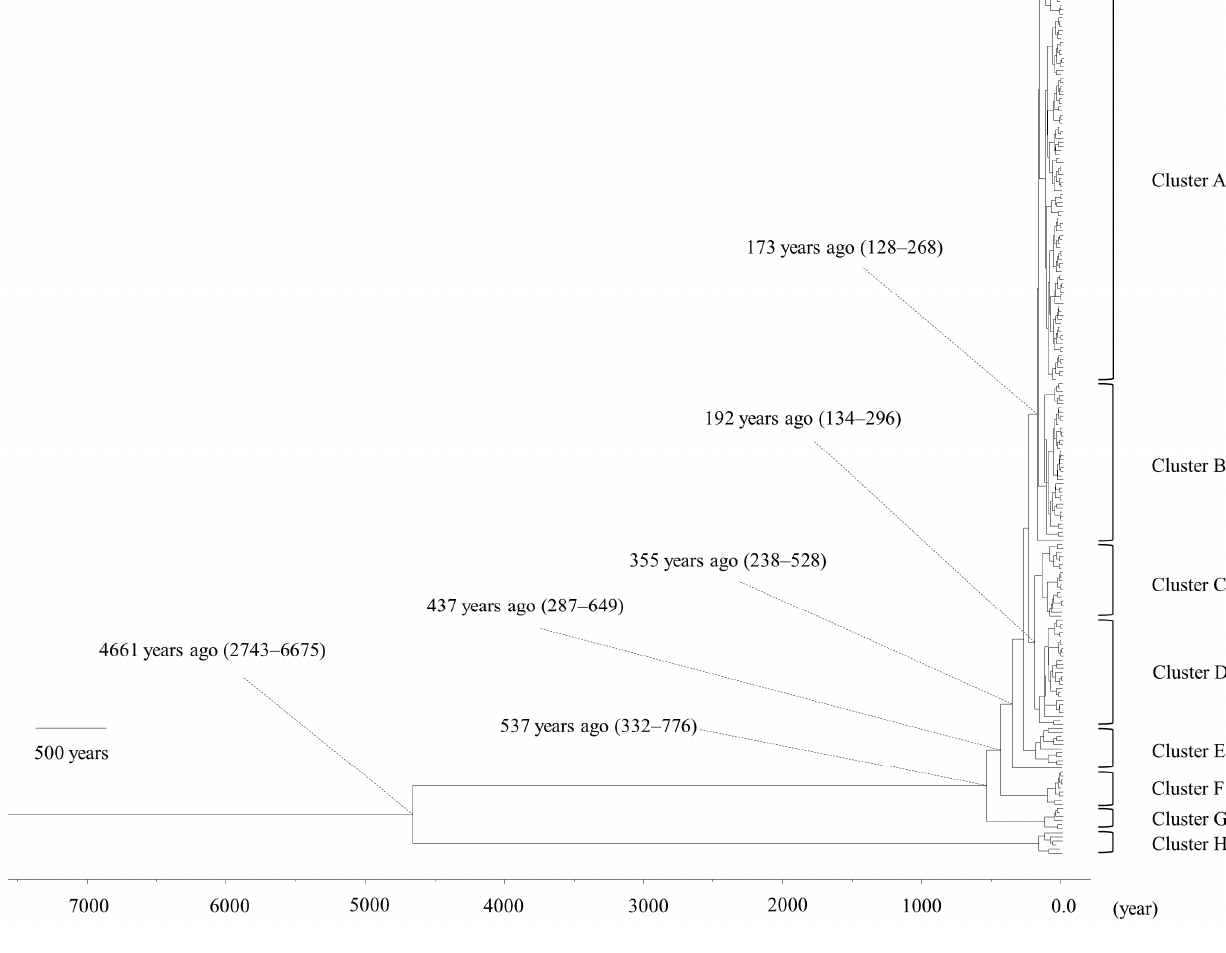
Figure 1. Phylogenetic tree of bla PDC , constructed using the Bayesian Markov Chain Monte Carlo method. The scale bar shows time (in years ago). The parentheses present the 95% highest posterior density (HPD).